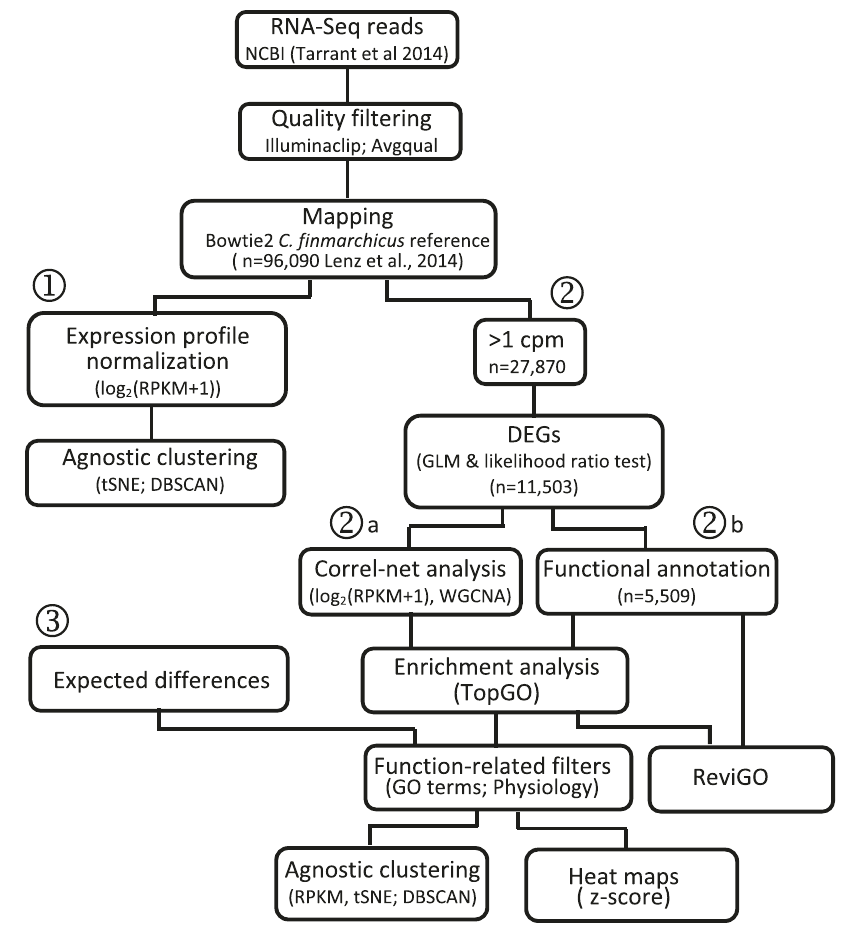
Fig. 1 Diagram of work fl ow. Three different strategies used to assess the physiological ecology of copepods in the different samples are laid out using circled numbers. Initial steps included downloading of RNA-Seq data, removal of low-quality reads and sequence trimming followed by mapping against the Gulf of Maine Calanus fi nmarchicus annotated reference transcriptome (96 K transcripts) using Bowtie2. The mapped count data were normalized and log- transformed before dimensionality reduction by t-SNE and identi fi cation of clusters using DBSCAN (strategy 1). For differential gene expression analysis (DEGs), the mapped count data were entered into EdgeR for statistical testing using a generalized linear model (GLM) (strategy 2). The downstream analysis involved weighted correlation network analysis (WGCNA) on the log-transformed expression of the DEGs (sub-strategy 2a). SwissProt-based annotations for the DEGs were retrieved from the reference transcriptome and distribution of DEG function was visualized using ReviGO (sub-strategy 2b). DEGs from the GLM analysis and WGCNA modules were assessed for enriched processes (TopGO). Enrichment results in combination with expected differences in physiology were used to generate GO fi lters and retrieve log-transformed relative expression of all genes in the reference annotated to a speci fi c fi lter for additional t-SNE and DBSCAN analyses (strategy 3). Gene expression patterns were visualized as z-scores in